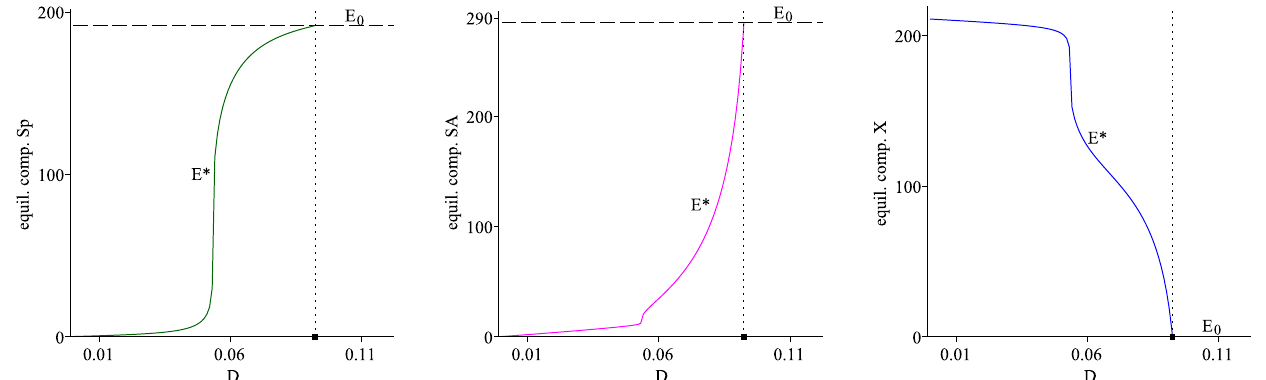
Figure 2. Components of the interior equilibrium E ∗ (solid lines) and of the washout equilibrium E 0 (dash lines). The vertical dot line passes through D max